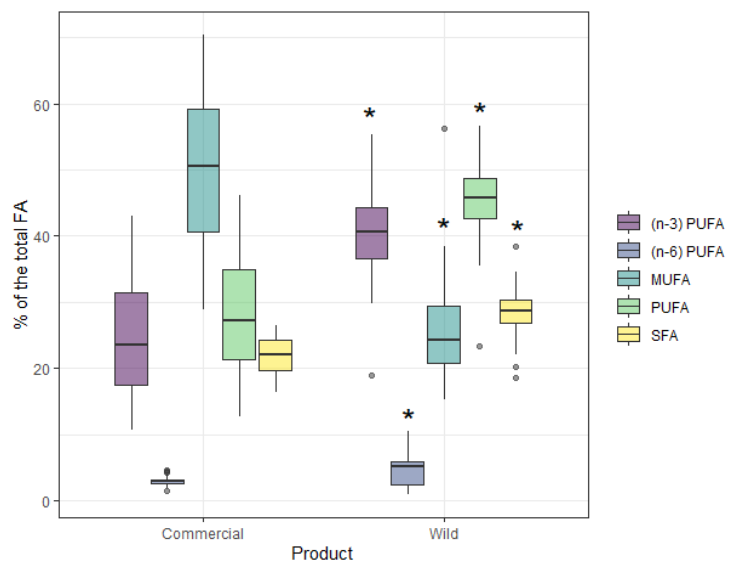
Figure 8. The content of main fatty acids classes in muscle tissue from the wild and commercial beaked redfish Sebastes mentella . Note: *—significantly ( p ≤ 0.05) different between wild and commercial product.